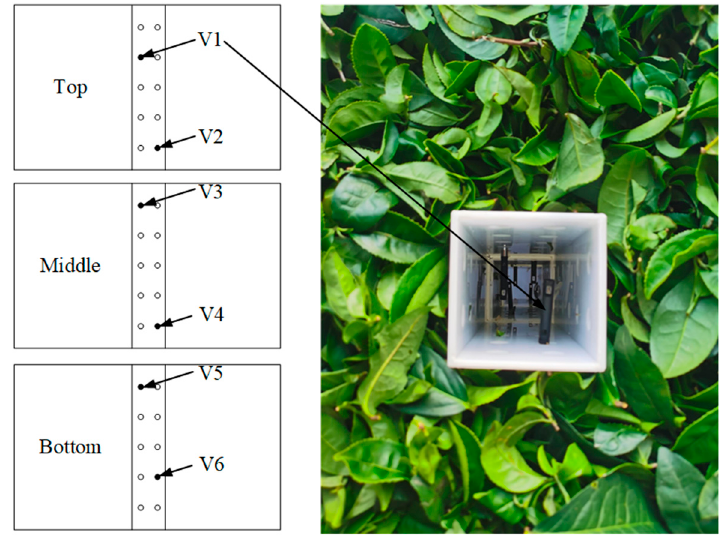
Figure 5. The arrangement of velocity sensors in the ventilation duct.